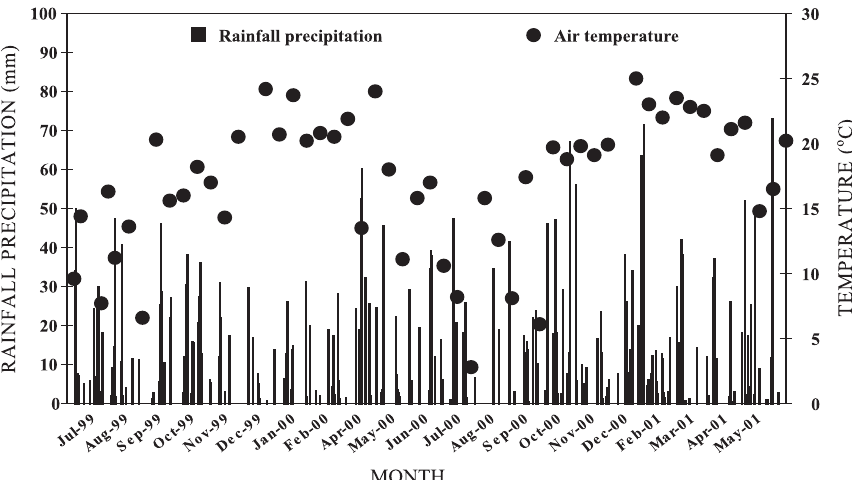
Figure 1. Rainfall precipitation and air temperature during the evaluation period of CO June 7, 1999 to June 4,